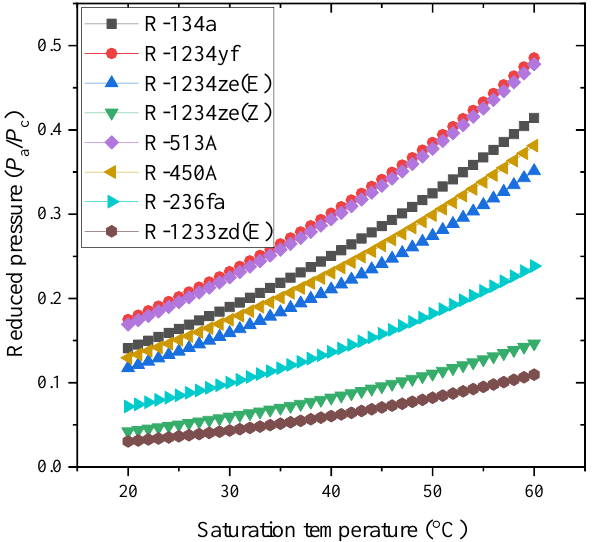
Figure 20. Saturation temperature vs. liquid pressures of alternative refrigerants to R-134a [1]. According to Dobson and Chato [86], the condensation heat transfer mechanism can be divided into three regimes: a shear-dominated flow regime, a gravity-dominated flow regime, and an intermediate flow region. The experimental results and analysis reveal that mass flux and vapor quality have significant effects on HTC in shear-dominated flow regimes. In contrast, in the gravity-dominated flow regime, the local HTC is mostly influenced by the temperature difference between the wall subcool temperatures, while both aforementioned heat transfer mechanisms exist in the intermediate flow